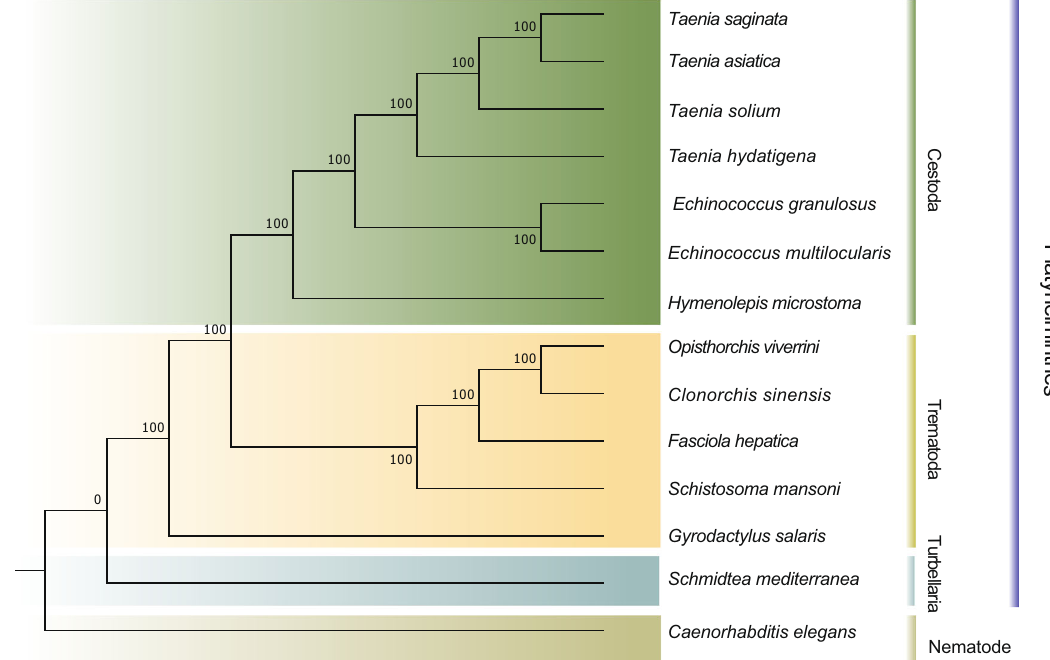
Fig. 5 Phylogenetic relationship between T. hydatigena and other worms. The phylogeny was inferred from concatenated proteins of single-copy ortholog genes ( n = 253). The branch lengths of the tree are not proportional to substitutions per site. The gene sets used in this analysis were retrieved from Wormbase